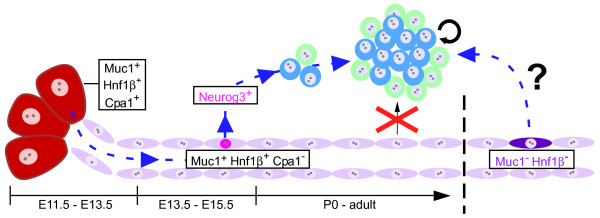
Dynamic differentiation potential within theexocrine pancreas. Multipotent pancreatic progenitors (E11.5-E13.5) express the digestive enzyme Cpa1, which is later restricted to acinar cells (E14.5-adult), together with Muc1 and Hnf1β [20]. While Cpa1+ cells cease contribution to islets from approximately E13.5 [7], Muc1+/Hnf1β+ cells continue to give rise to Neurog3+ endocrine precursors (pink nuclei) and islets (blue and green) through at least E15.5. From around birth, Muc1+ and Hnf1β+ cells no longer contribute to the endocrine lineage, and mature islets are maintained by self-replication of those pre-existing. However, it remains a formal possibility that a subpopulation exists within the ductal network (dark blue cytoplasm), expressing neither Muc1 nor Hnf1β, from which β-cells continue to arise after birth.